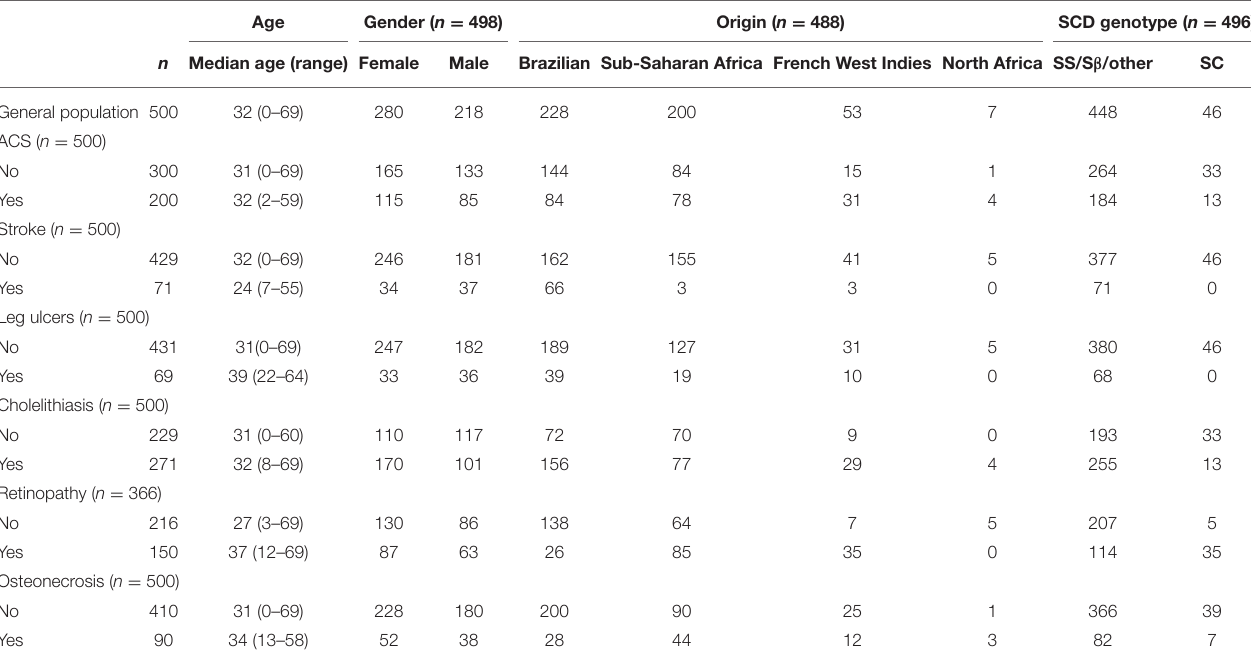
TABLE 1 | Demography according to clinical